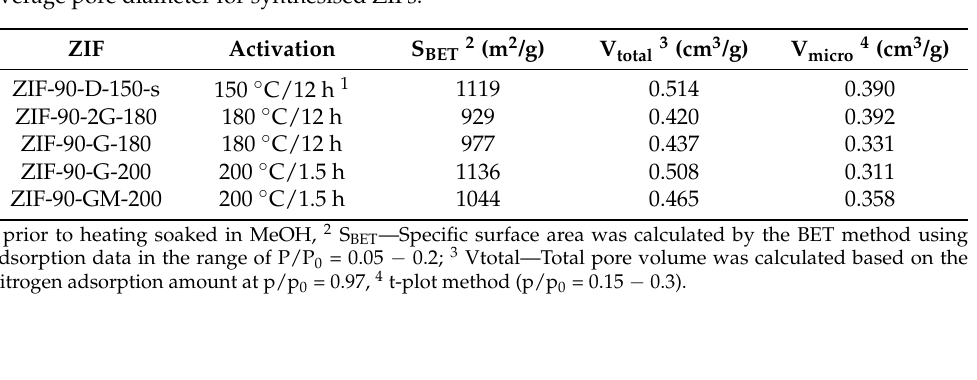
Figure 5. N 2 adsorption isotherms for fully activated (ZIF-90-G-200, ZIF-90-GM-200), while the inset shows partially activated (ZIF-90-G-180) and reference (ZIF-90-D-150-s) samples. Table 2. Activation parameters, Calculated Brunauer–Emmett–Teller (BET), total pore volume, and average pore diameter for synthesised